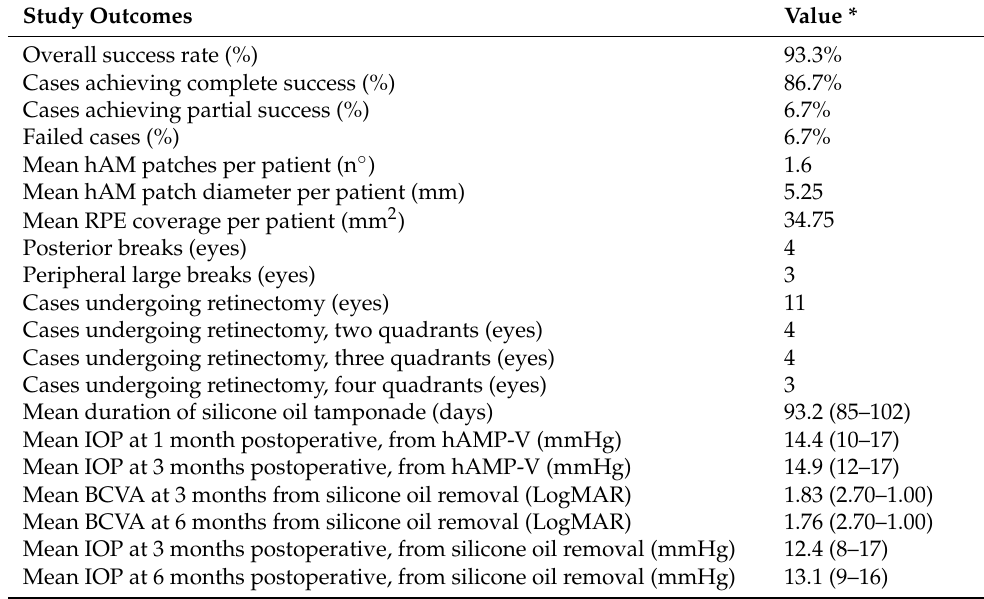
Table 2. Outcome measures and intraoperative